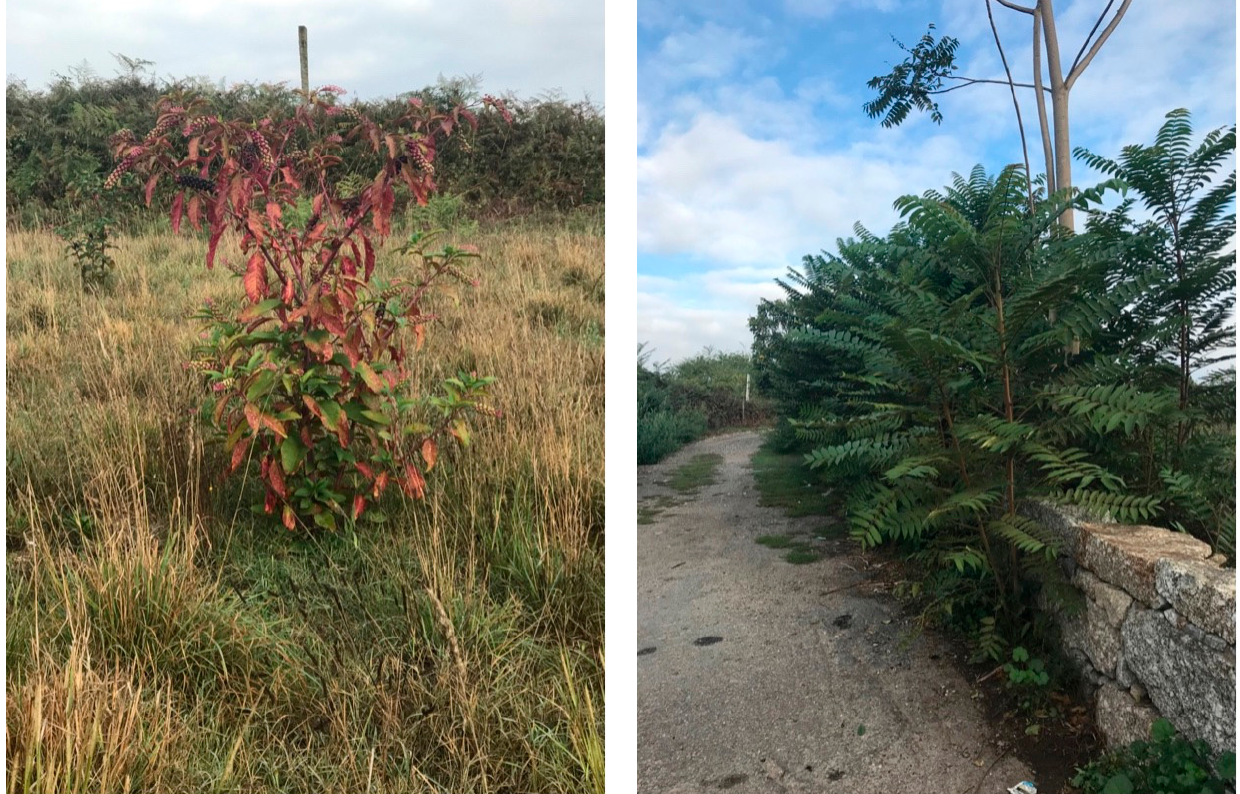
Figure 4. Phytolacca americana ( left side ) and Ailanthus altissima ( right side ). The distribution of forest areas by the territory follows the reverse model of the distribution of urbanized areas, with the forest areas being concentrated more in the parishes of the northern part of the municipality. At the same time, the main urban centers can be found in the southern region of the municipality. However, in the South, it is also possible to find a very significant forest spot, which corresponds to the mountain of Santa Catarina, locally known as Penha. Concerning the distribution of the species Eucalyptus globulus and Pinus pinaster , those are mainly associated with the most significant continuous forests